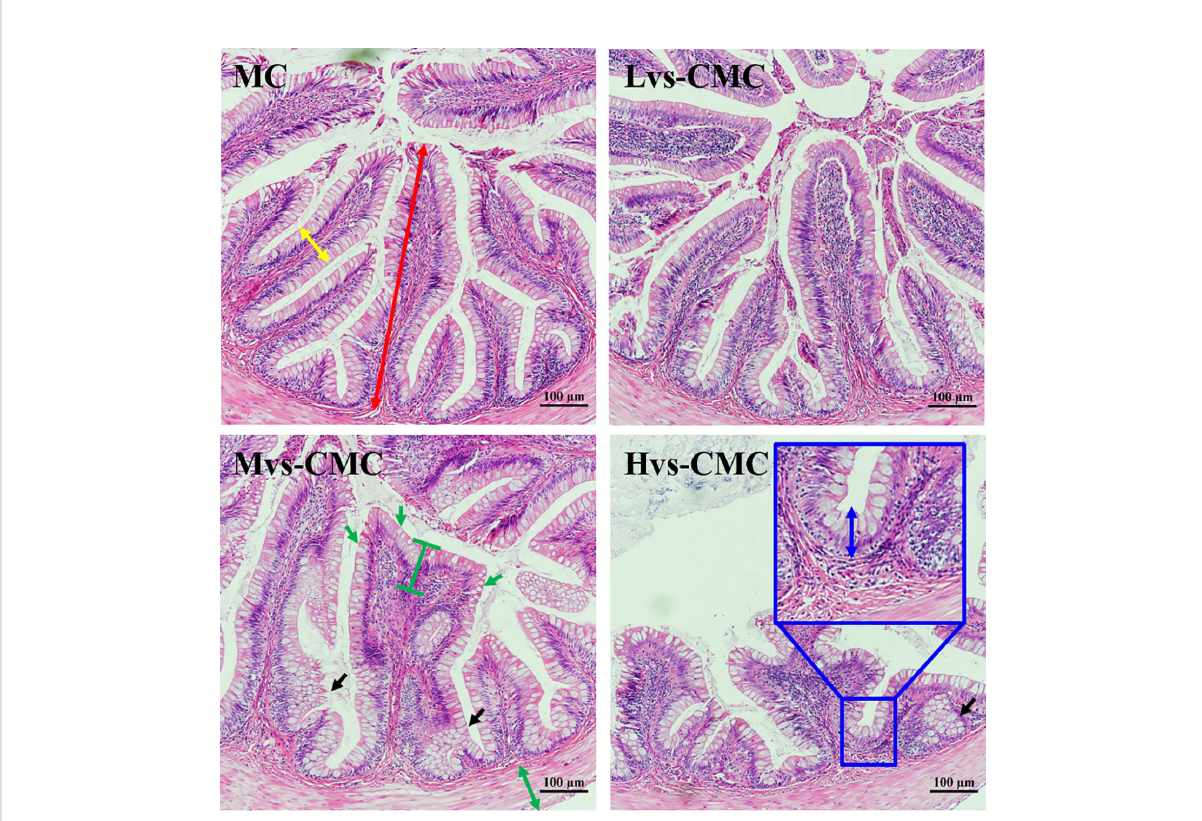
FIGURE 1 Hindgut hematoxylin – eosin (HE) staining of largemouth bass fed with the test diets (magni fi cation, ×200). Yellow double-sided arrow , villus width; black arrow , crypt cell proliferation; red double-sided arrow , villus height; green double-sided arrow , muscular thickness; green arrow , goblet cell; blue double-sided arrow , crypt